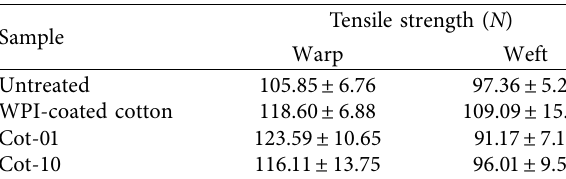
Table 3: Tensile properties of fabric